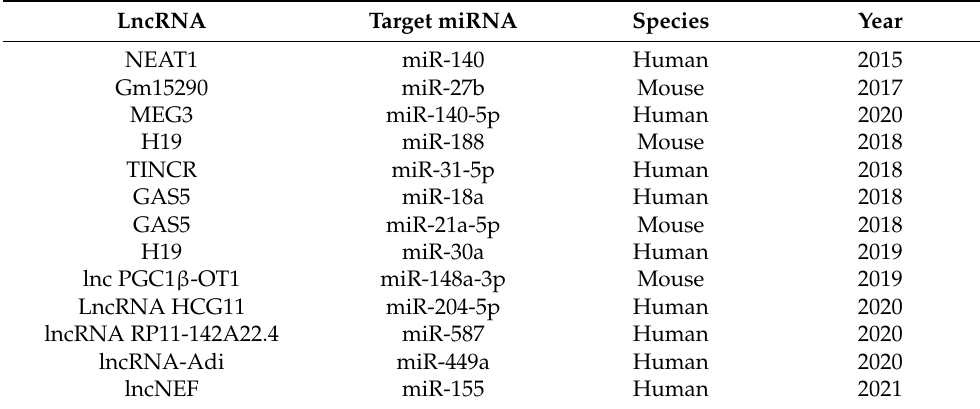
Table 1. Adipogenesis and development-related lncRNAs (miRNA